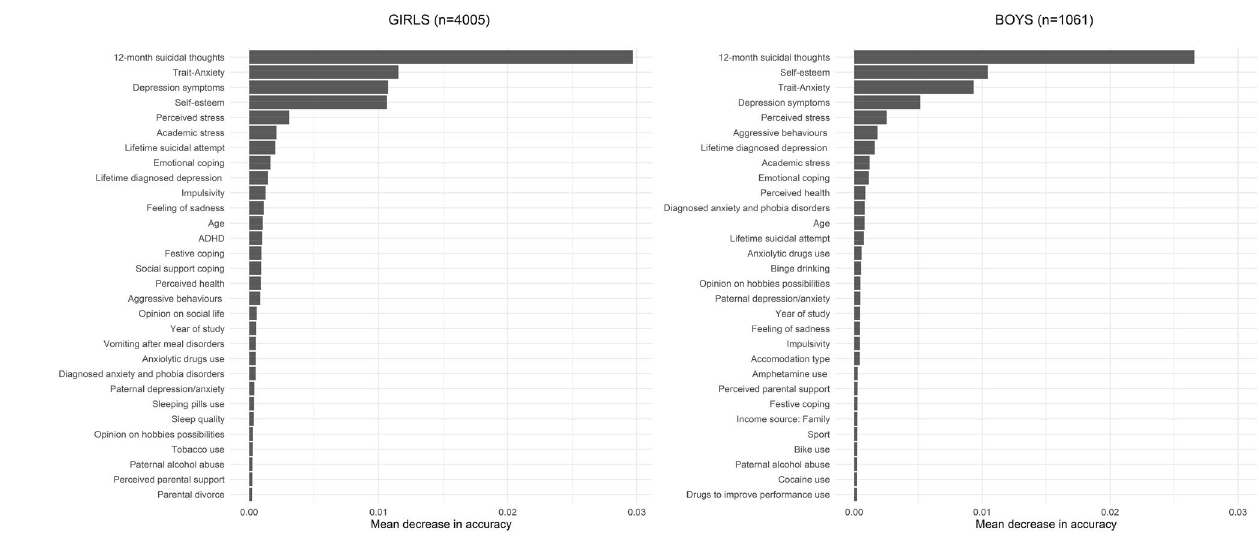
Figure 2. Ranking of the importance of baseline variables in a random forests model for predicting one-year suicidal thoughts and behaviours, stratified by